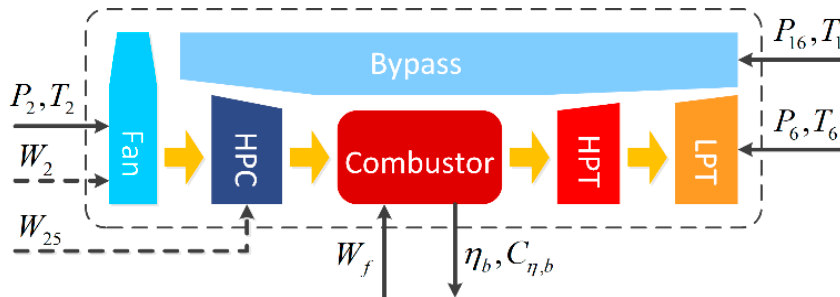
Figure 3. Combustor inverse calculation.